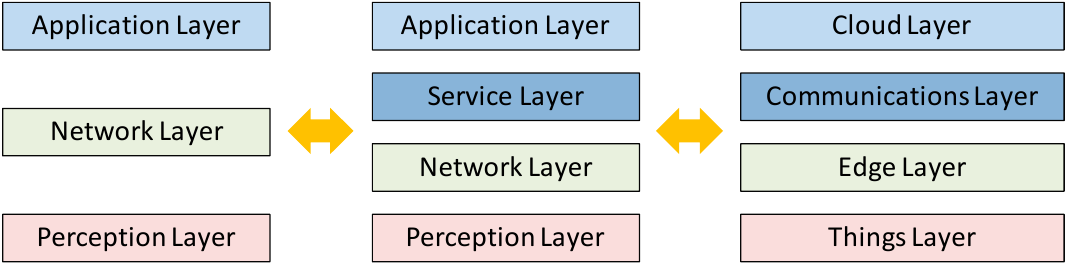
Figure 29. Evolution of the layered model in IoT architecture.